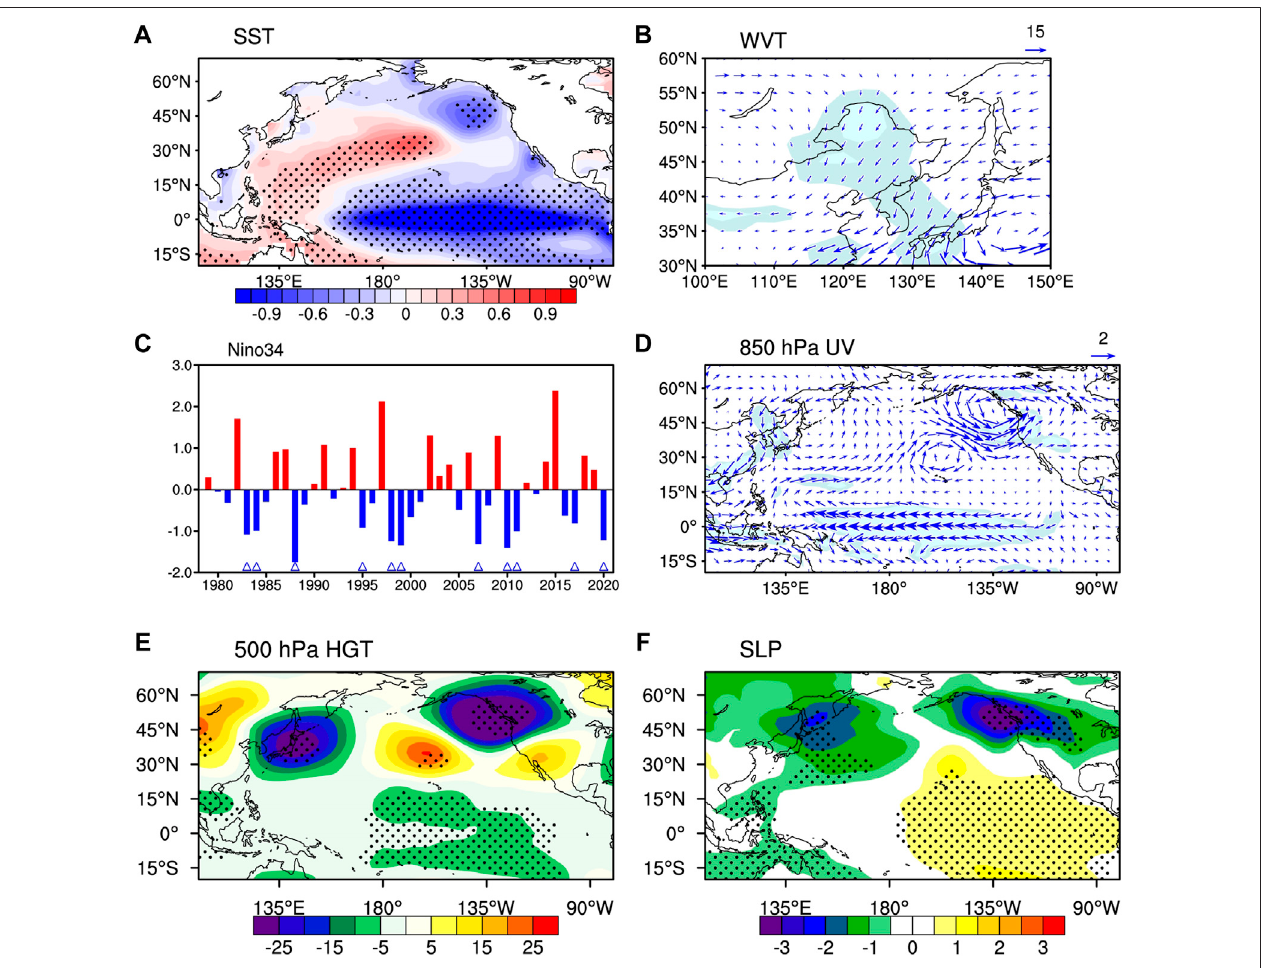
FIGURE9| Compositedifferencesinmonthlymean (A) SST(unit: ° C), (B) verticallyintegratedWVT(vectors;unit:kg m − 1s − 1 ), (C) timeseriesofnormalizedNiño3.4 SST, (D) 850-hPa winds (vectors; unit: m s − 1 ), (E) 500-hPa HGT (unit: gpm), and (F) SLP (unit: hPa). The gray shading in (B , D) denotes where the anomalies are signi fi cant at the 90% con fi dence level. Stippling in (A,E,F) denotes where the anomalies are signi fi cant at the 90% con fi dence level. The differences are between the eight strongest La Niña years (1983, 1984, 1988, 1995, 1998, 1999, 2007, 2010, 2011, and 2017) and the climatology for